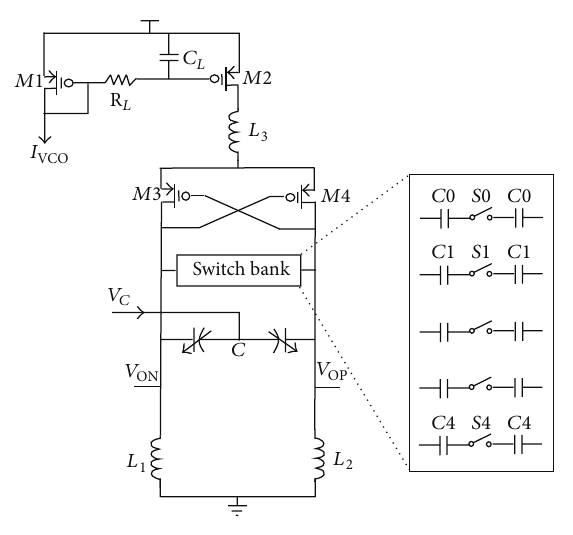
Figure 9: LC VCO